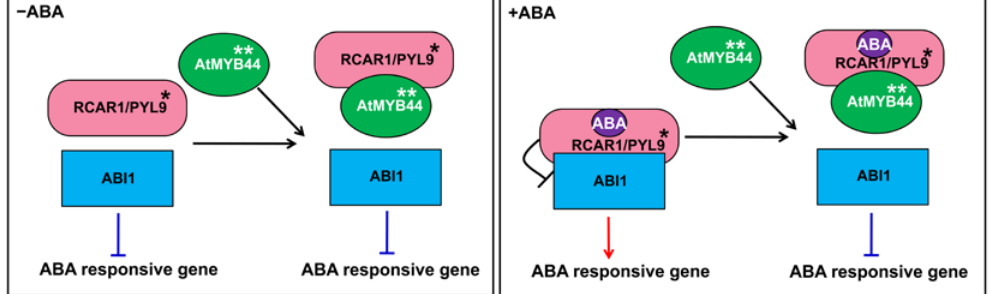
Figure 7. A hypothetical model for the action mechanism of AtMYB44 in ABA signaling. In the absence of ABA, AtMYB44 interacts with RCAR1/PYL9, but does not affect ABI1 activity. Upon ABA perception, AtMYB44 competes with ABI1 for binding to RCAR1/PYL9, releasing the inhibitory of RCAR1/PYL9 on ABI1 activity and thus down-regulating the expression of ABA-responsive genes. “ * ” indicates that this component may also include RCAR2/PYL7, RCAR3/PYL8 and RCAR4/PYL10. “ ** ” indicates that this component may also include AtMYB70, AtMYB73 and